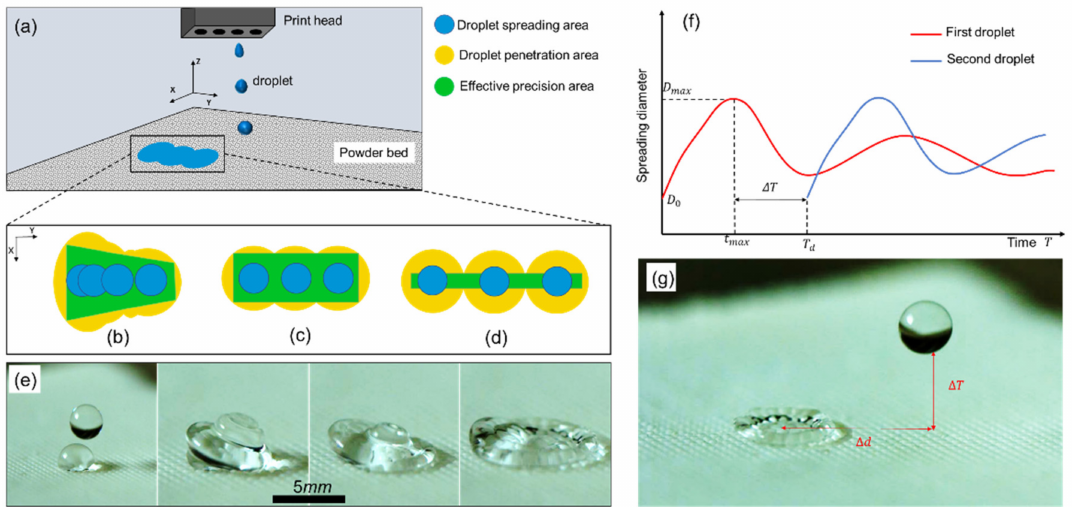
Figure 4. The illustration of the interaction mechanism of multiple droplets spreading. The light blue area in ( a ) is the binder droplet spreading area. ( b – d ) shows the relationship among spreading, penetration and printing precision. The light blue region was the droplet spreading area, the yellow region was the droplet penetration area, and the green region was the effective precision area of the printed sample. ( e ) is a captured diagram of millimeter-scale droplets to explain the droplets spreading interference. ( f , g ) are the schematic diagram of the spreading of two droplets. The curves of two droplets spreading behavior against time are shown in ( f ). ( g ) the photograph of droplets captured on a millimeter scale was used to explain the spreading mechanism. The t max is the maximum spreading time, T d is droplets spreading interval, D max is the largest spreading diameter, ∆ T is the time difference between the two